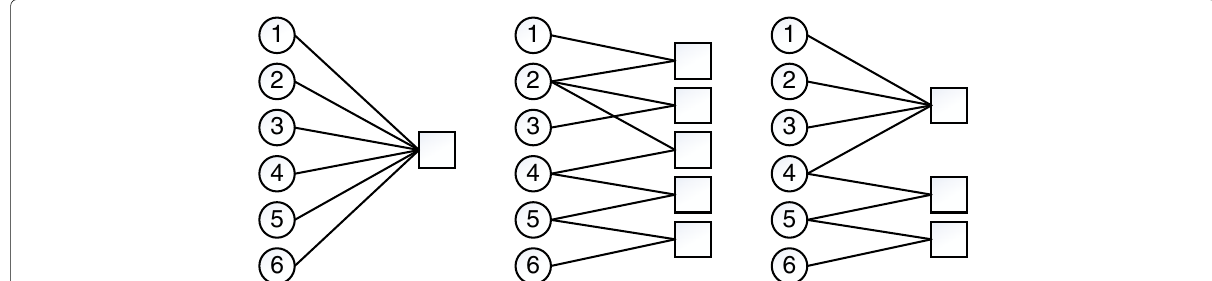
Fig. 2 Communication graphs of C-CADMM, D-CADMM, and H-CADMM for example 1. Circles represent nodes, while squares represent hyperedges. Solid lines between nodes and hyperedges indicate nodes belonging to